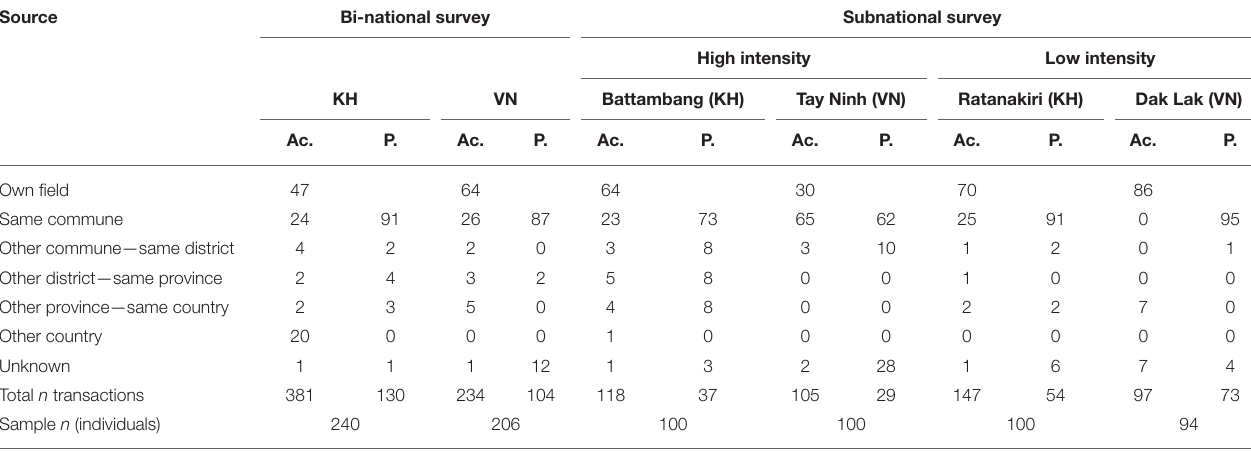
TABLE 6 | Geography of stake exchange in the 2016 field season from both bi-national and subnational surveys, displayed in percentages of overall stake transactions recorded at each site, with KH indicating Cambodia and VN indicating Vietnam.